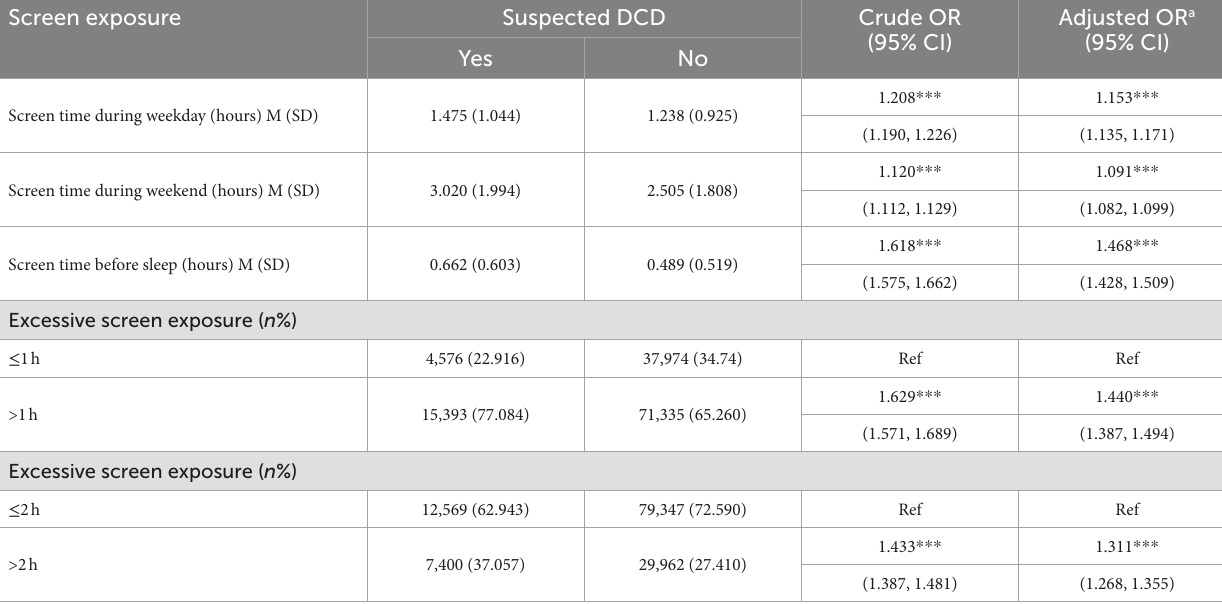
TABLE 3 The association between screen time and risk of DCD in preschoolers ( n =